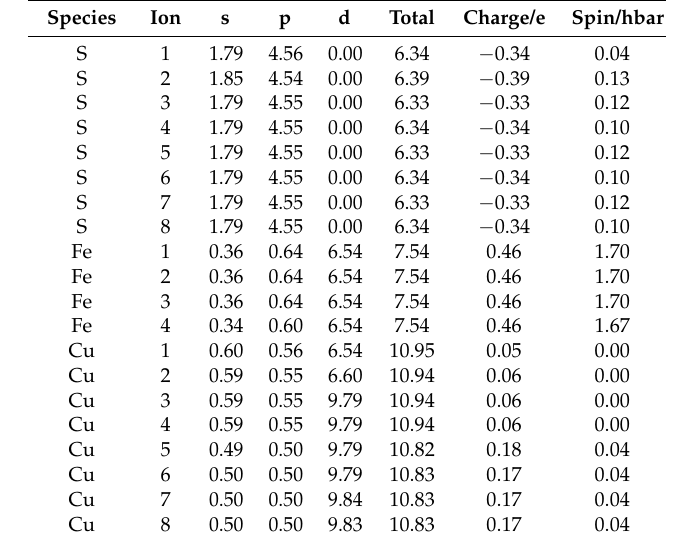
Table 4. Mulliken population of bornite in DFT calculation (CASTEP module of Materials Studio 6.0 software package, PBE density function, Hubbard + U